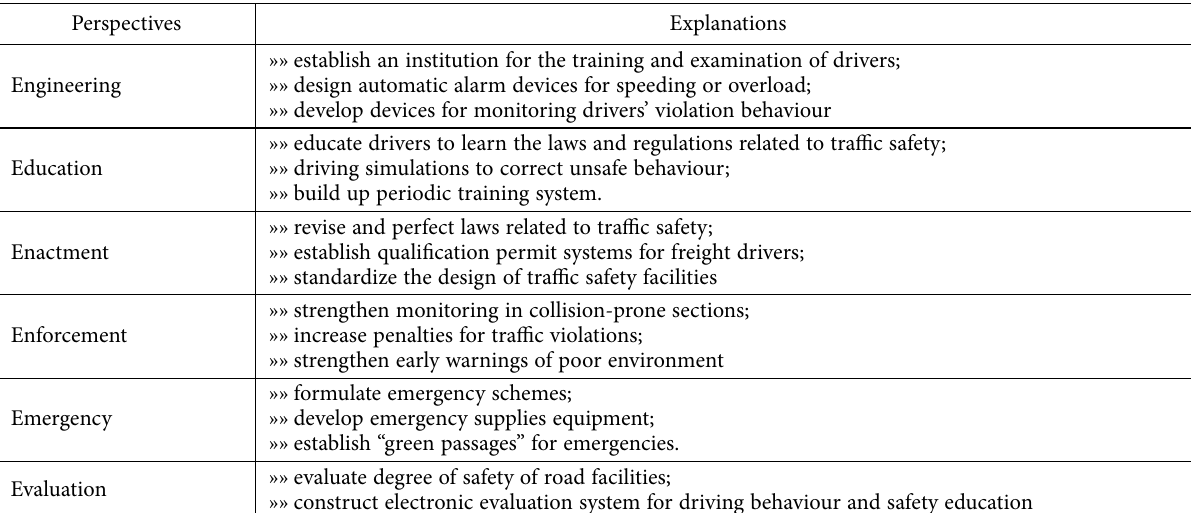
Table 10. “6E” measures for traffic safety